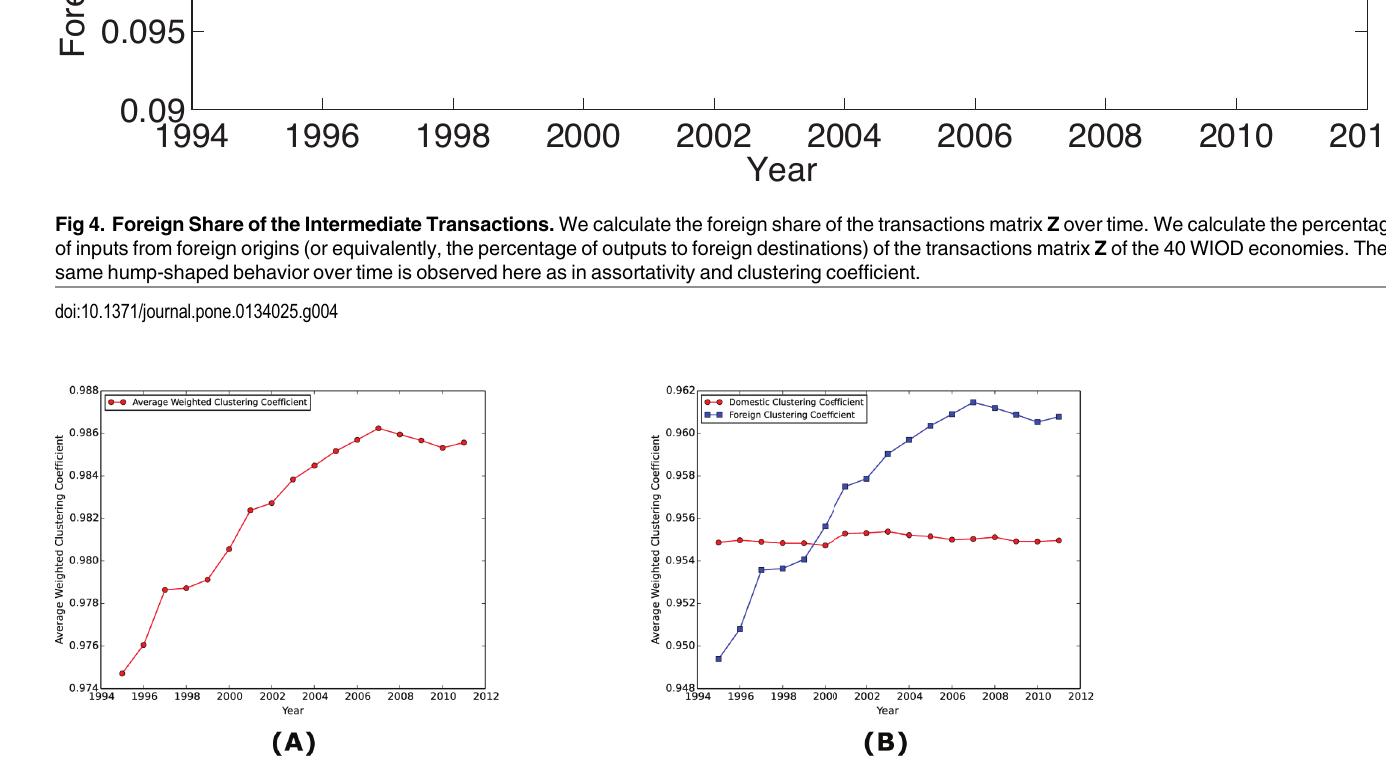
Fig 5. Clustering coefficient of the WION over time. Panel (A) shows the average weighted clustering coefficient of the WION over time. Panel (B) further decomposes the clustering coefficient into domestic clustering coefficient and foreign clustering coefficient. Clearly the behavior in Panel (A) is more explained by the foreign clustering